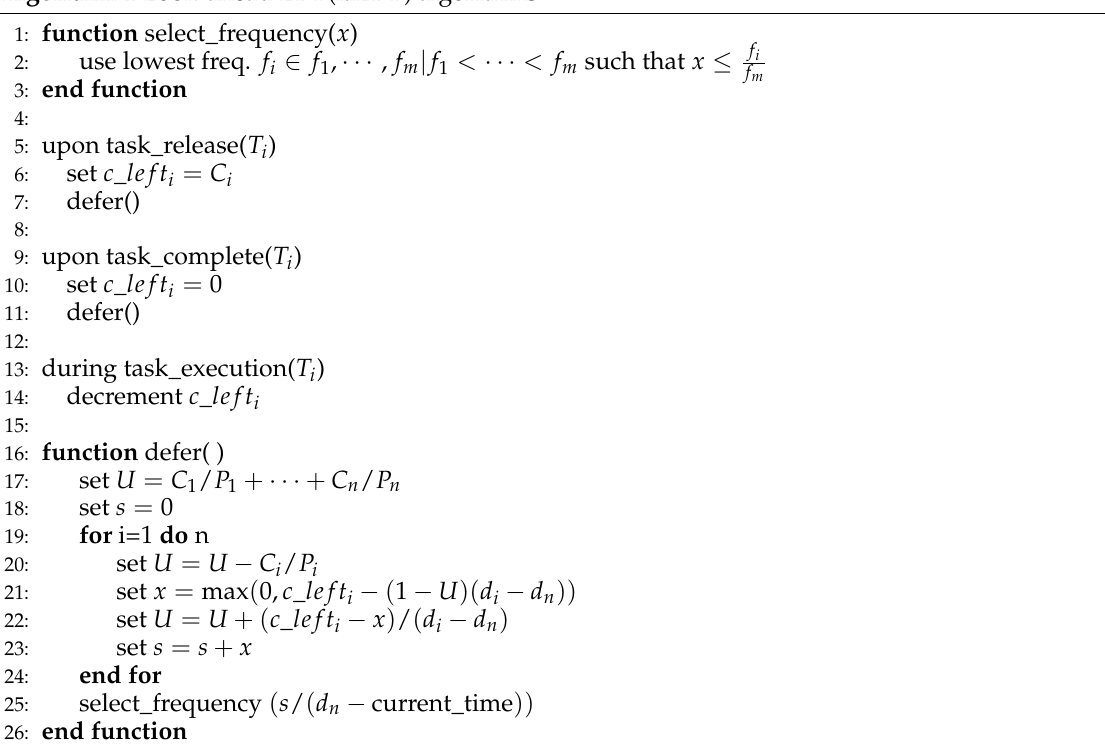
Algorithm 1 Look-ahead EDF(laEDF) algorithms.